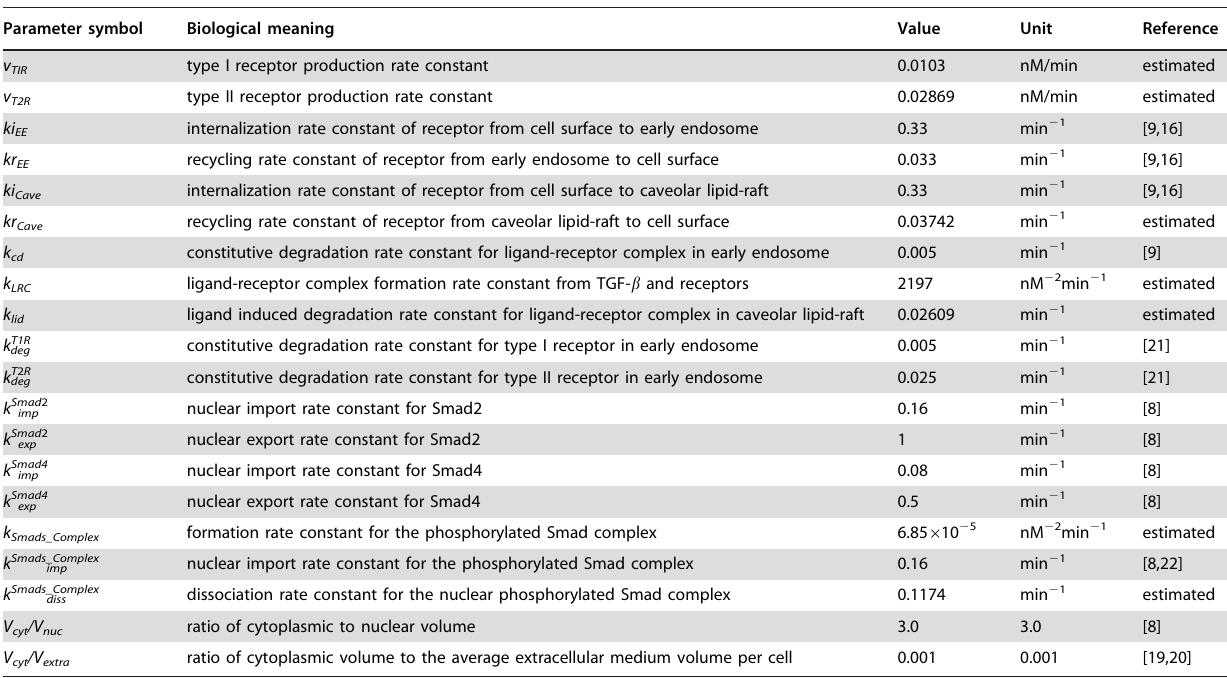
respectively. A typical cell culture experiment would have a cell density of 1.0 6 10 6 cells/ml. The average extracellular medium volume per cell ( V extra ) is about 1.0 6 10 2 9 Liter. Hence, the volume ratio of cytoplasm to extracellular medium ( set to a value of 0.001.